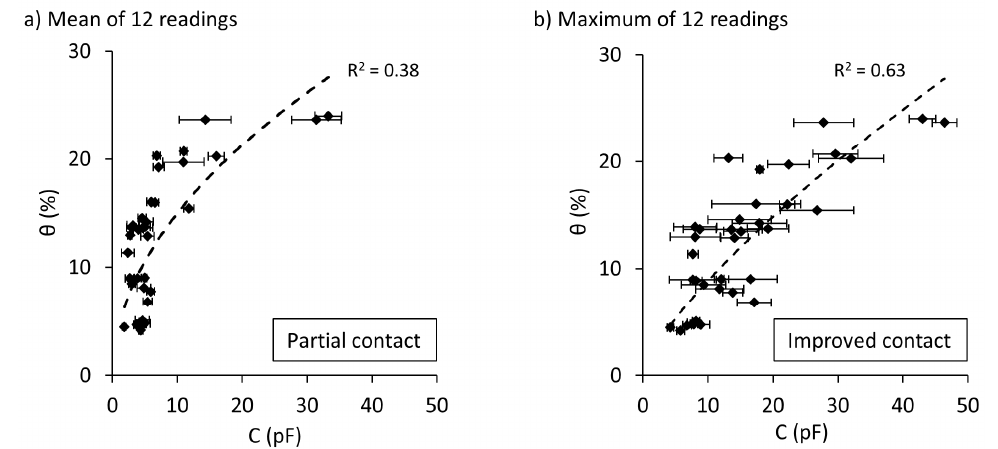
Figure 11. Effects of soil sensor coupling on the estimation of volumetric water content, θ, using the Rectangular sensor on the Brighton Group Sand: ( a ) Mean of 12 readings (Partial contact), ( b ) Maximum of 12 readings (Improved contact). Data adapted from [80].